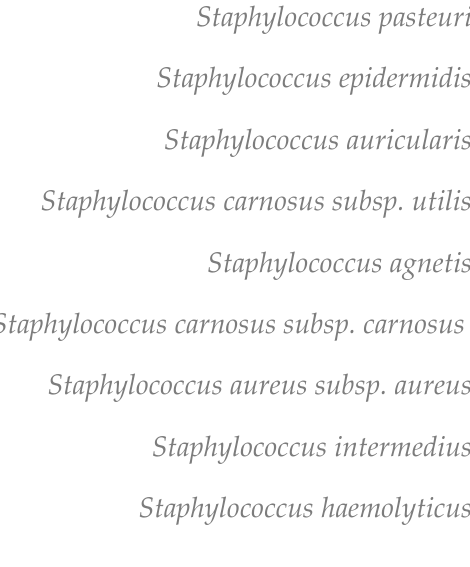
Figure 1. Number and species of Staphylococci isolated from the hands of healthcare professionals. Among the isolates tested for the blaZ gene of the chromosomal material, none of the samples, regardless of species, was positive. On the other hand, the femA gene was widespread among the isolates, being present in 100% of S. intermedius , S. epidermidis , S. carnosus subsp. utilis , and S. pasteuri tested; and positive in 50% of S. carnosus subsp. carnosus and S. auricularis and 30% of S. haemolyticus samples. However, none of the S. agnetis and S. aureus subsp. aureus were positive for chromoso- mal femA . As for mecA , a single isolate of S. haemolyticus tested positive for the chromosomal gene (Table 1). The femA gene showed a higher proportion in S. intermedius when compared with S. haemolyticus , p = 0.003. When compared with all Staphylococcus species, the result showed a higher proportion in S. intermedius , p = 0.004; thus, the S. intermedius species is associated with the femA chromosomal